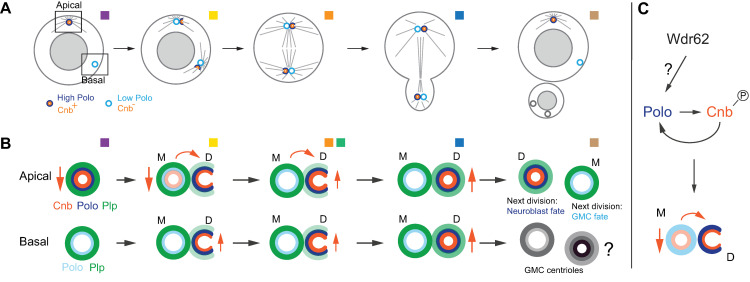
Centrosome asymmetry is primed in mitosis through dynamic Cnb and Polo localization changes.(A) Model: Centriolar asymmetry,—here shown for Polo (dark and light blue) and Cnb (orange),—occurs during mitosis, coupled to centriole-to-centrosome as known as mitotic centriole conversion. Polo and Cnb are enriched or restricted to the newly formed daughter centriole on both the apical and basal centrosome. The ensuing Cnb+ and Polo-rich centriole maintains MTOC activity, retaining it in the self-renewed neuroblast. Details for the apical and basal centrosome are shown in panel B. Cnb (orange) and Polo (blue) localize dynamically on the forming daughter centriole and are down-regulated on the mother centriole from prophase onwards. The basal centrosome directly up-regulates Cnb on the daughter centriole where Polo is also enriched. Cnb’s dynamic localization most likely entails both down- and up-regulation in prophase and prometaphase and up-regulation in anaphase and telophase, respectively (vertical orange arrows), as well as direct protein transfer (curved arrows). Plp (green) remains on the mother, potentially increasing in intensity and appearing on the daughter centriole in prometaphase. For the apical centrosome, the centriole containing less Plp, gained Cnb and Polo, and is destined to be inherited by the self-renewed neuroblast (indicated with “neuroblast fate”) in the next division, whereas the centriole containing higher Plp and lower Polo levels is destined to be inherited by the GMC (indicated with “GMC fate”). The fate of the basal centrioles and subsequent marker distribution is unknown (represented by gray circles). (C) Cnb and Polo co-depend on each other for their enrichment on the daughter centriole. Wdr62 is necessary for Polo’s asymmetric centriolar localization, although the molecular mechanism is unclear. Cnb, Centrobin; GMC, ganglion mother cell; MTOC, microtubule organizing center; Plp, PCNT-like protein; Wdr62, WD40 repeat protein 62.